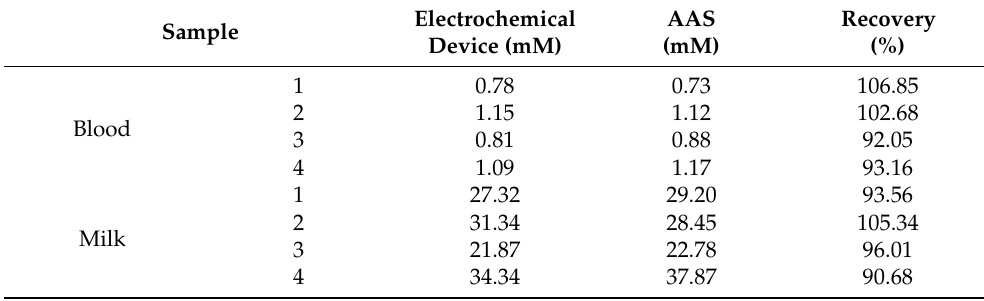
Table 3. Ca 2+ concentrations in the real samples determined by the electrochemical device and